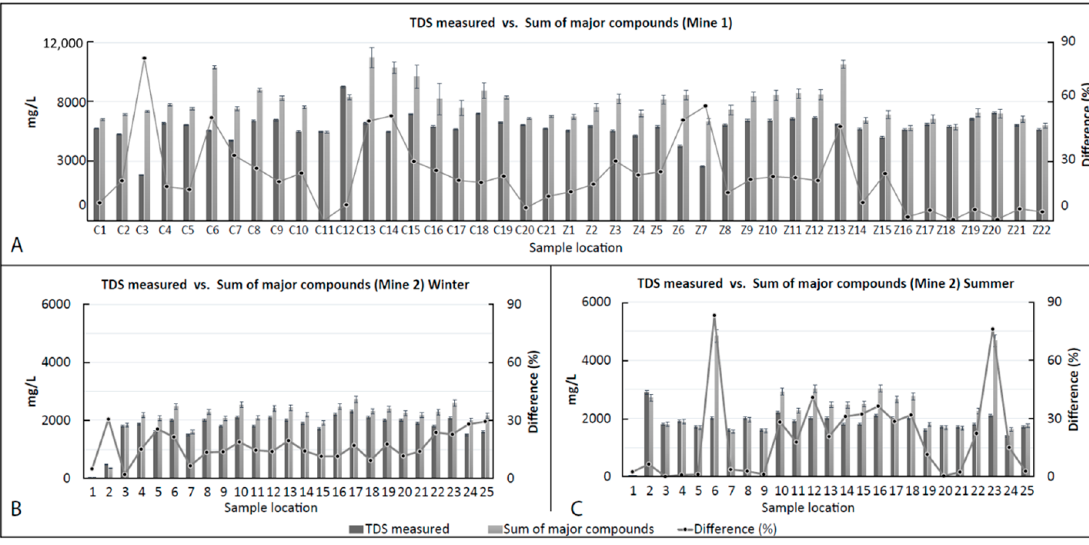
Figure 3. Balance of TDS calculated for samples from Mine 1 ( A ) and Mine 2 winter survey ( B ) and summer survey ( C ).